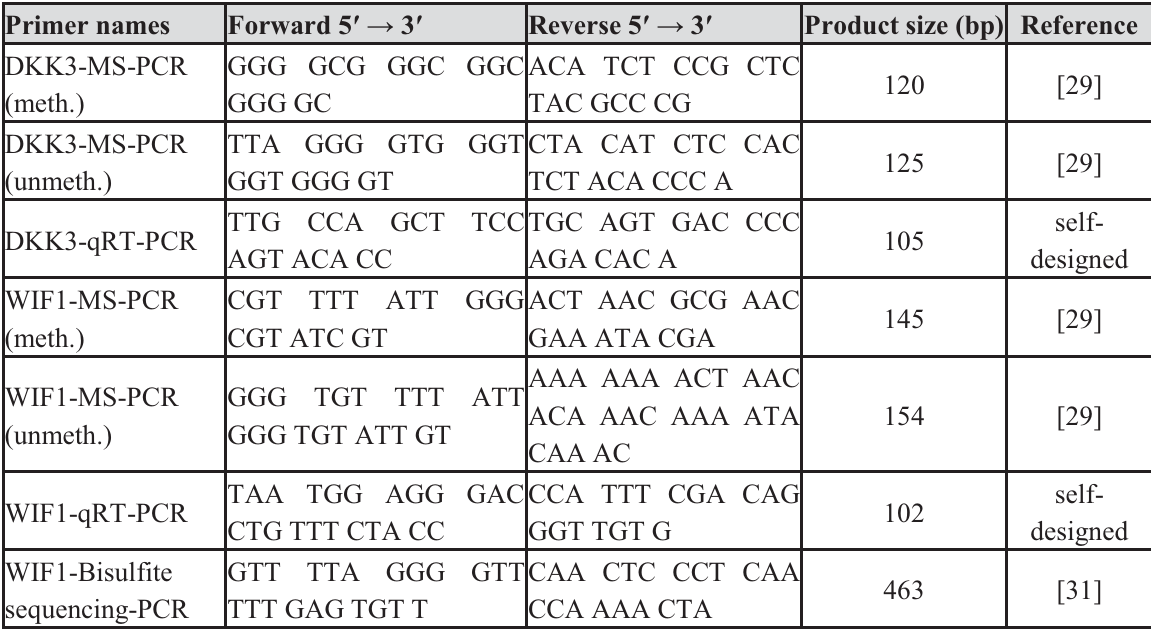
Table 1. Primers